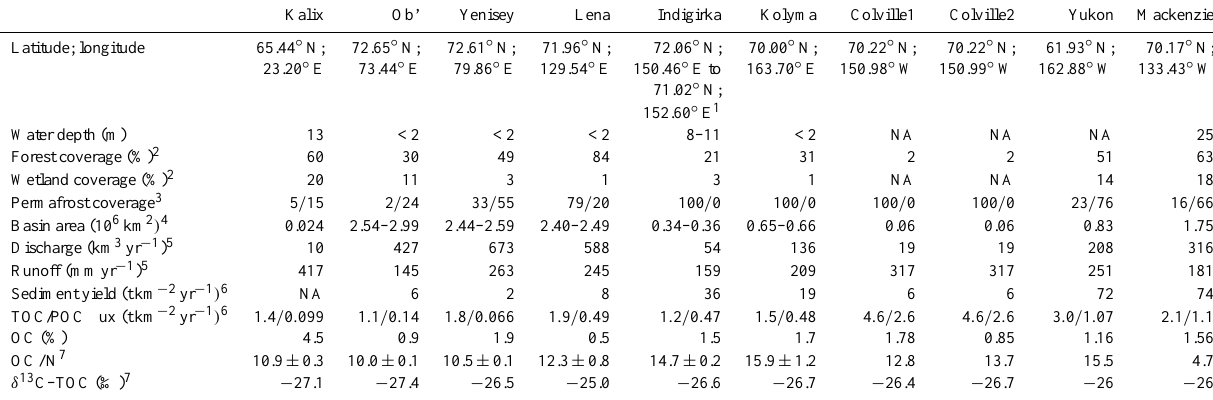
Table 1. Sample location, drainage basin characteristics and bulk sediment properties of the pan-Arctic rivers. Kalix Ob’ Yenisey Lena Indigirka Kolyma Colville1 Colville2 Yukon Mackenzie Latitude; longitude 65.44 ◦ N; 72.65 ◦ N;